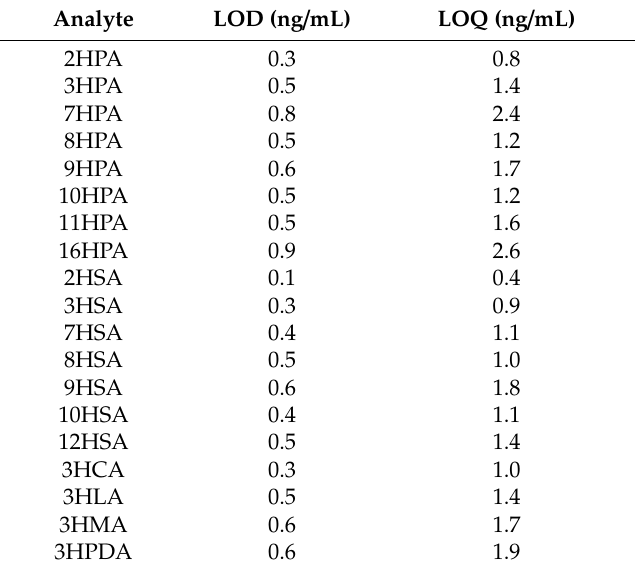
Table 2. Limits of detection (LOD) and quantification (LOQ).